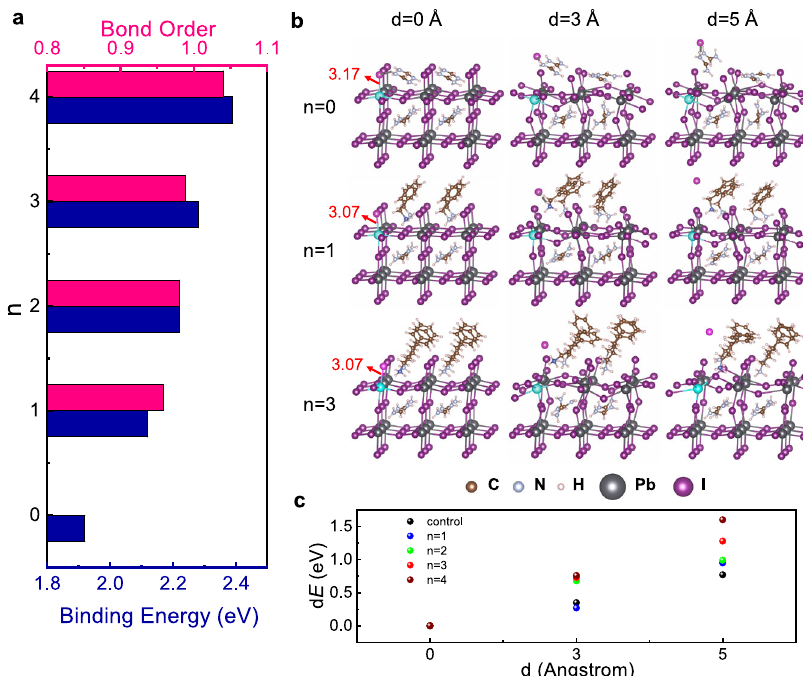
Fig. 4 DFT analysis of perovskite surface. DFT analysis of perovskite surfaces passivated by molecules of n = 0 (reference FAPbI 3 ) and n = 1 to n = 4. a Binding energy and bond order of the passivation molecules on the FAPbI 3 perovskite surface. b Schematic pathway of iodide migration on the passivated perovskite surfaces. From left to right are con fi gurations with zero iodide displacement (i.e., iodide ions are bonded in the lattice) and iodide displacement to distances of 3 and 5 Å away from the perovskite surface, respectively. From top to bottom are systems with molecules of n = 0 (reference FAPbI 3 ), n = 1, and n = 3, respectively. The mobile iodide and the most affected species, such as, the surface lead and the ammonium group (the nitrogen) of the molecule are highlighted in colors pink, cyan, and blue, respectively. c Relative energies along the iodide diffusion path for molecules with n = 0, 1 –